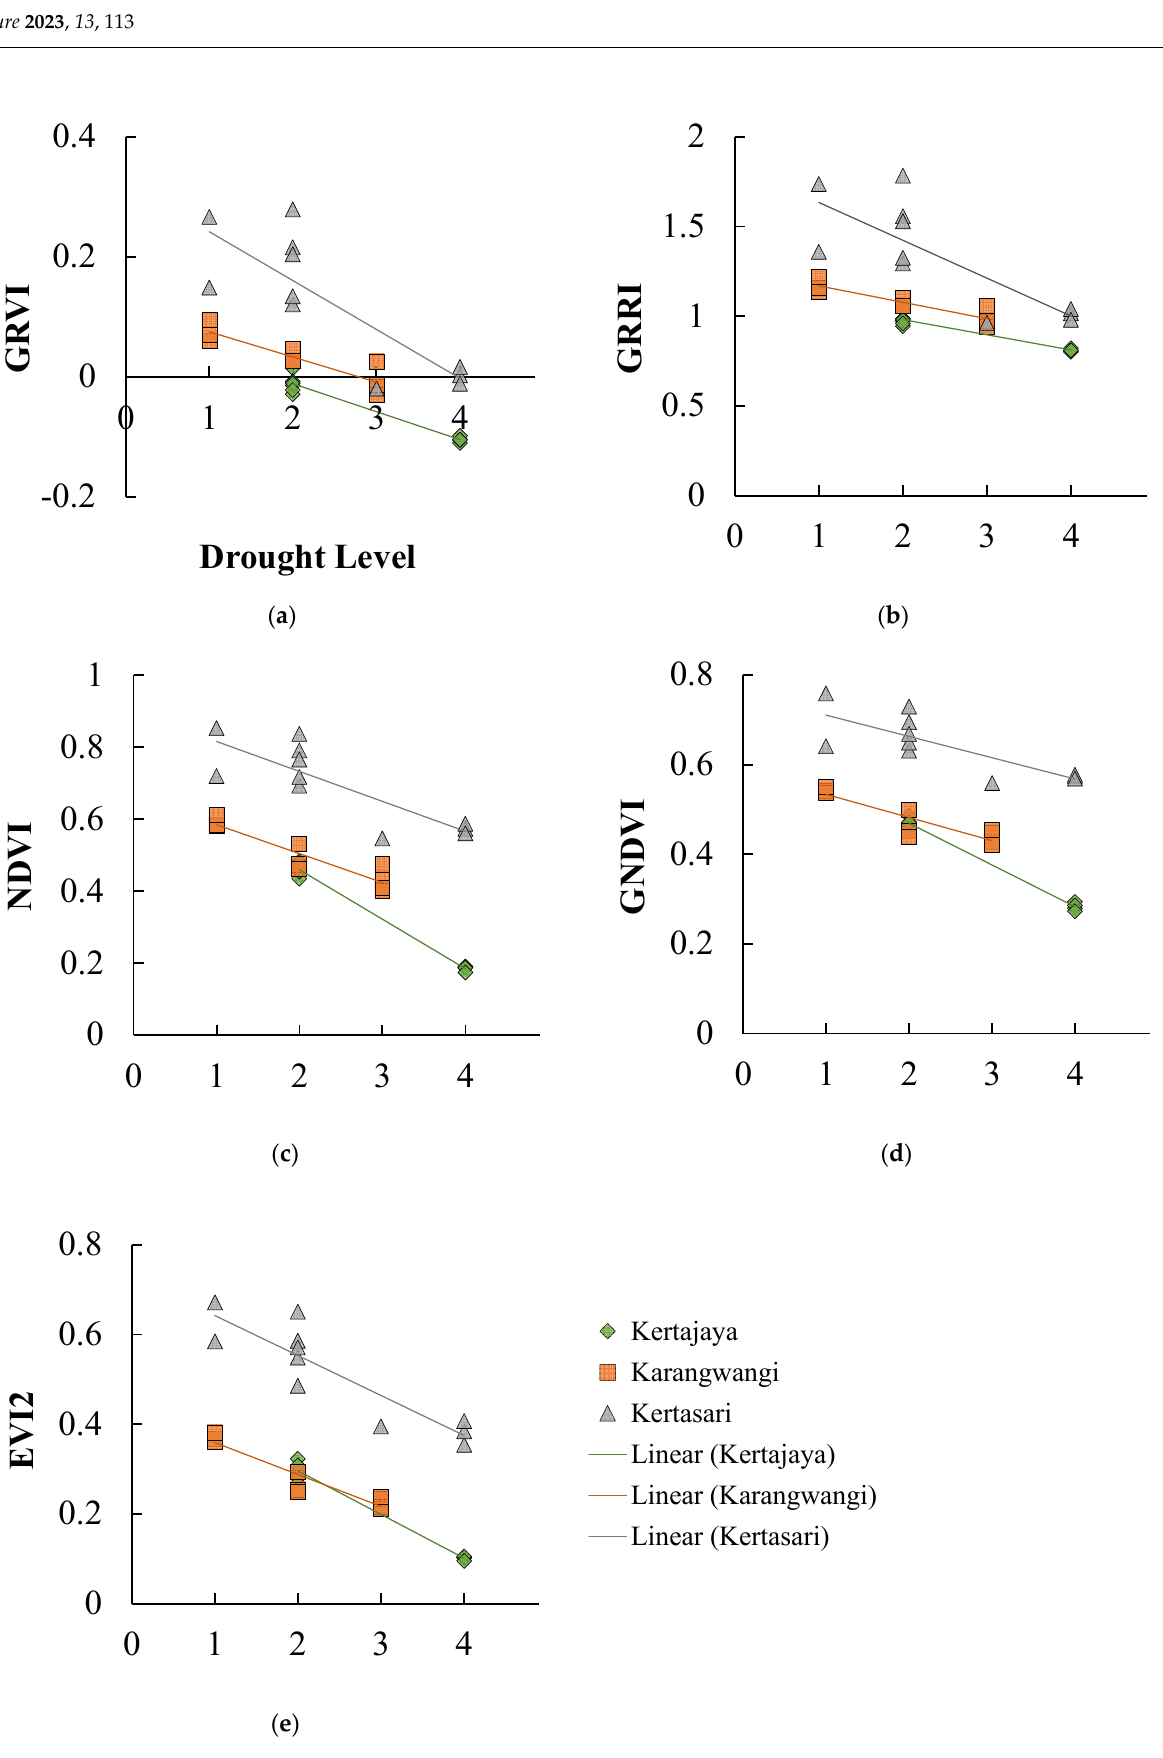
Figure 5. The linear relationships between vegetation index and drought level assessed by a pest observer in the 1st survey. ( a ) GRVI; ( b ) GRRI; ( c ) NDVI; ( d ) GNDVI; ( e ) EVI2. Table 6. Average determination coefficients of linear regression for DL against each VI for investi ‐ gated locations.